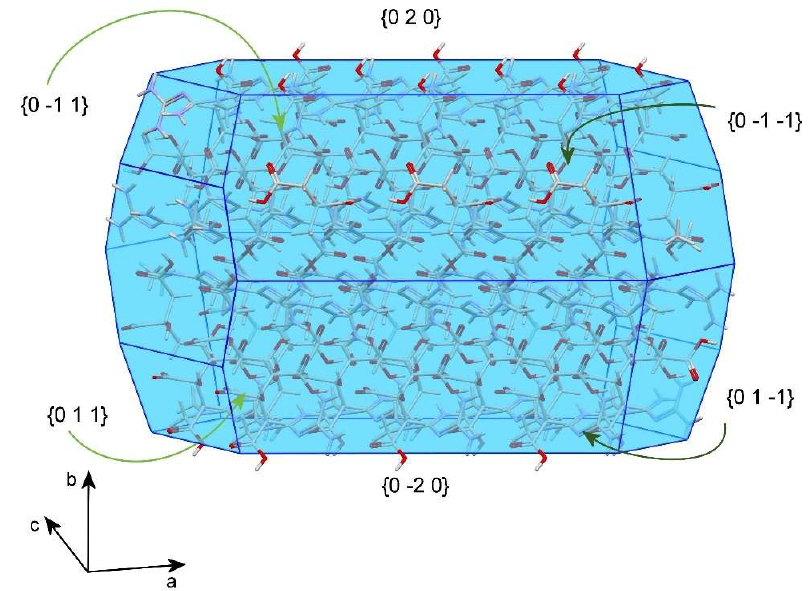
Figure 5. BFDH predicted morphology of MTF–CIT showing {0 2 0} and {0 −2 0} facets.